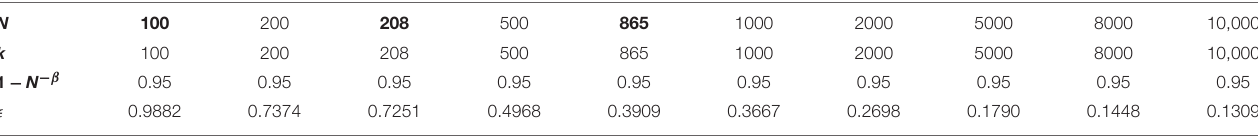
TABLE 7 | Accuracy of the distance preservation ǫ depending on sample size N and reduced dimension k for a given probability of success 1 − N − β in